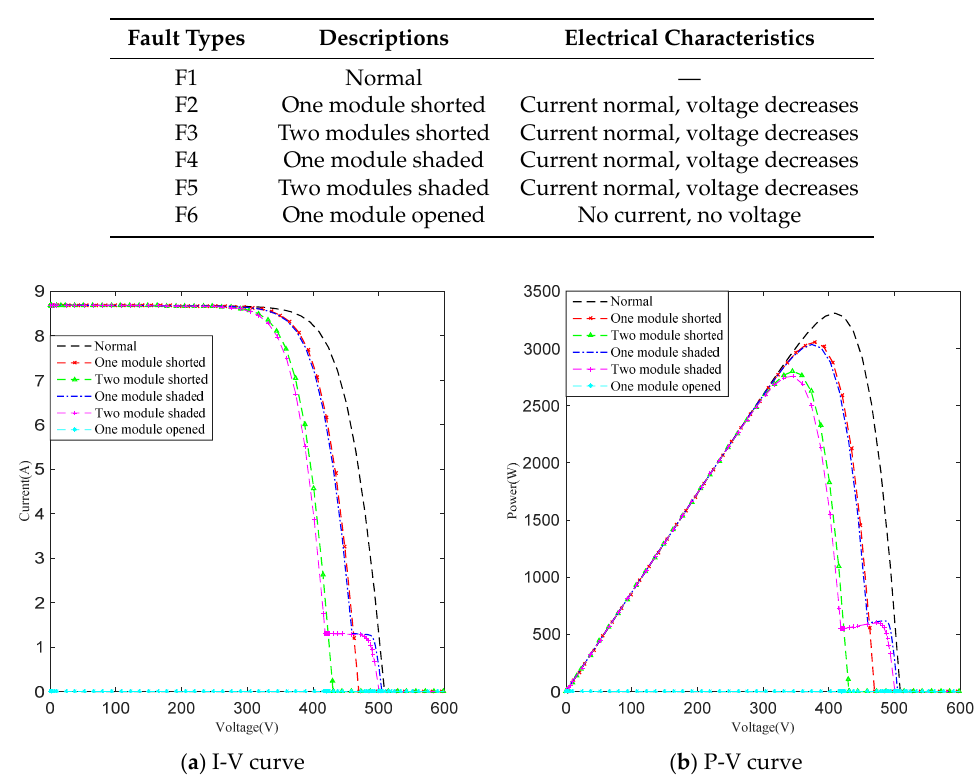
Figure 2. Output characteristic curves of PV array under different fault conditions, ( a ) I-V curve under different fault conditions; ( b ) P-V curve under different fault conditions.